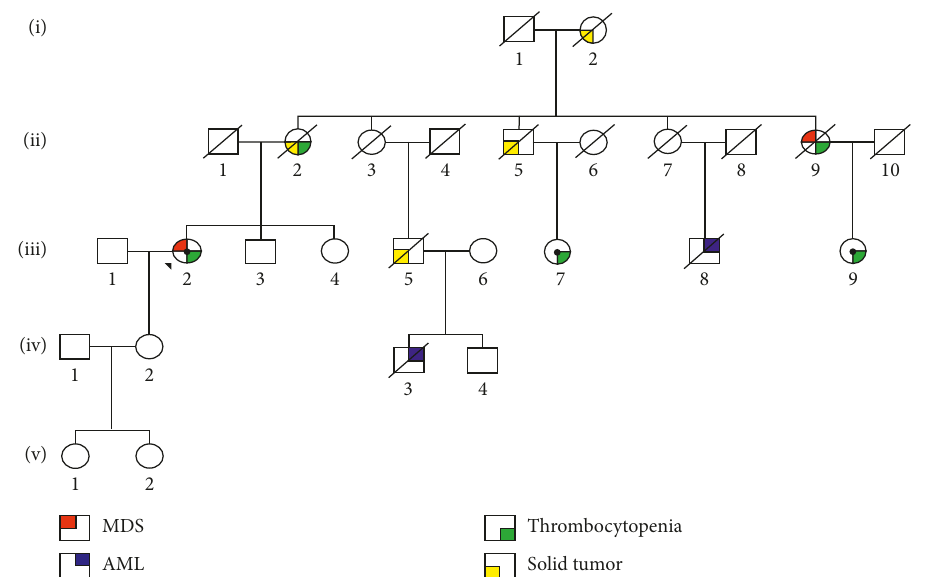
Figure 1: Case index pedigree (black arrow indicates the case index; black dot indicates subject presenting mutation; MDS syndrome; AML acute myeloid (cid:30)